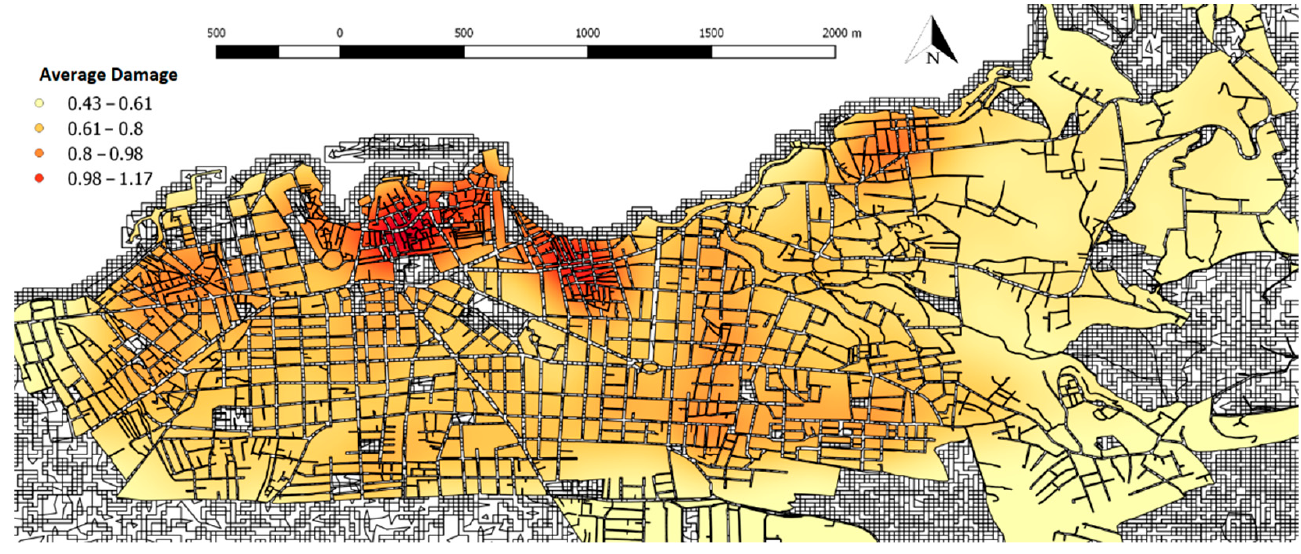
Figure 4. Estimated average degree of damage per building block.